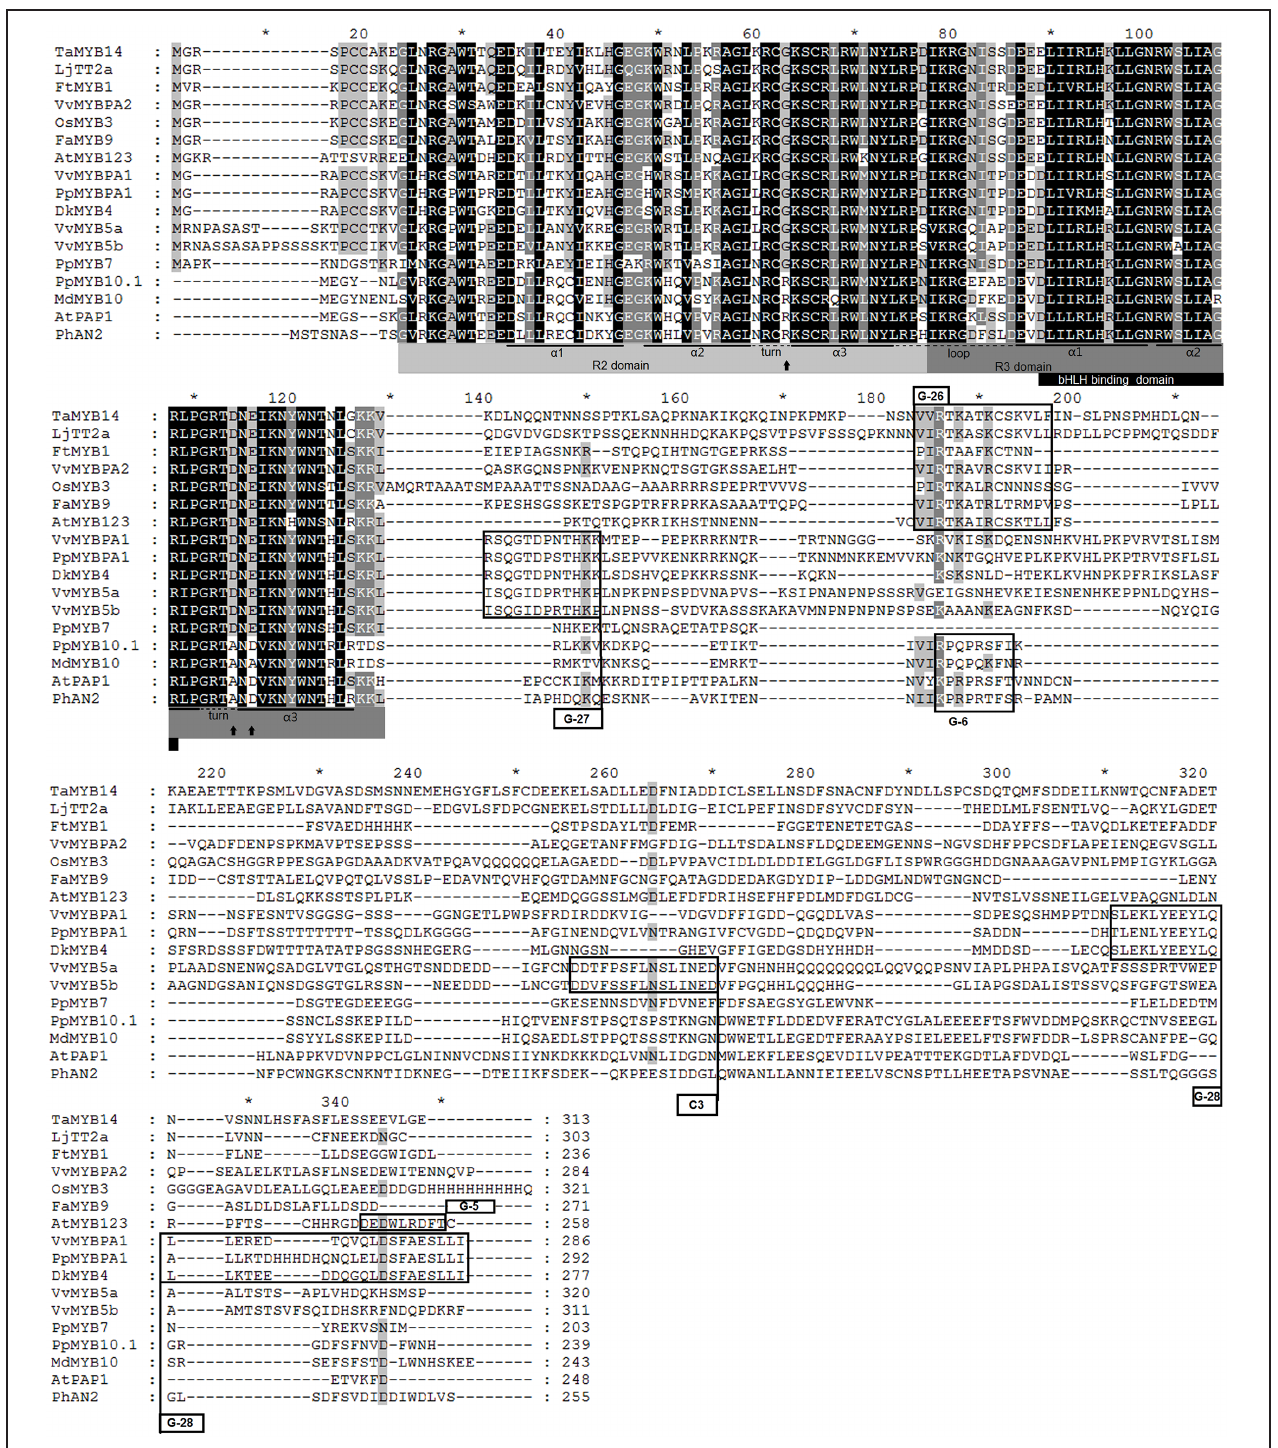
FIGURE 3 | Amino acid sequence alignment of the full length amino acid sequences of PpMYB7 and other known proanthocyanidin and anthocyanin MYB regulators in plants. Conserved residues are highlighted in black, and partial conservation is indicated in gray. The alpha helices of R2 and R3 repeats are indicated with black lines. Black arrows indicate key residues that mediate specificity for either the anthocyanin or PA pathway (Heppel et al., 2013). Conserved motifs in the C-terminal region (G-5, G-6, G-26, G-27, and G-28) were numbered according to Stracke et al. (2001) and Heppel et al. (2013), and C3 motif according to Deluc et al.